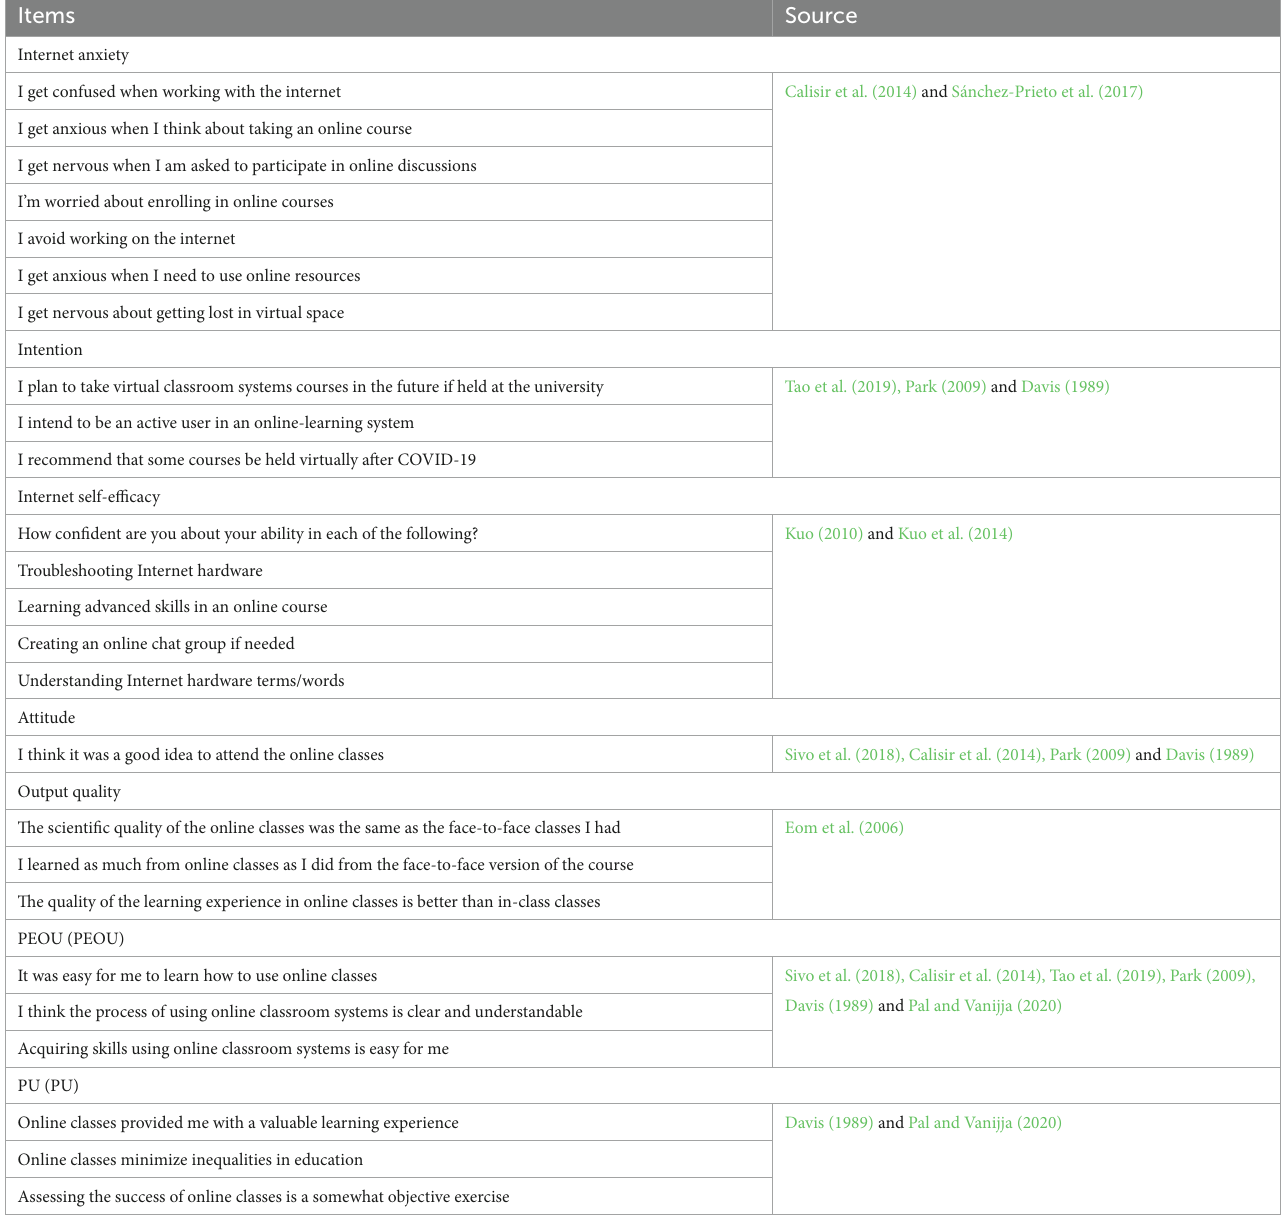
TABLE 1 Items of the extended TAM model and their sources.